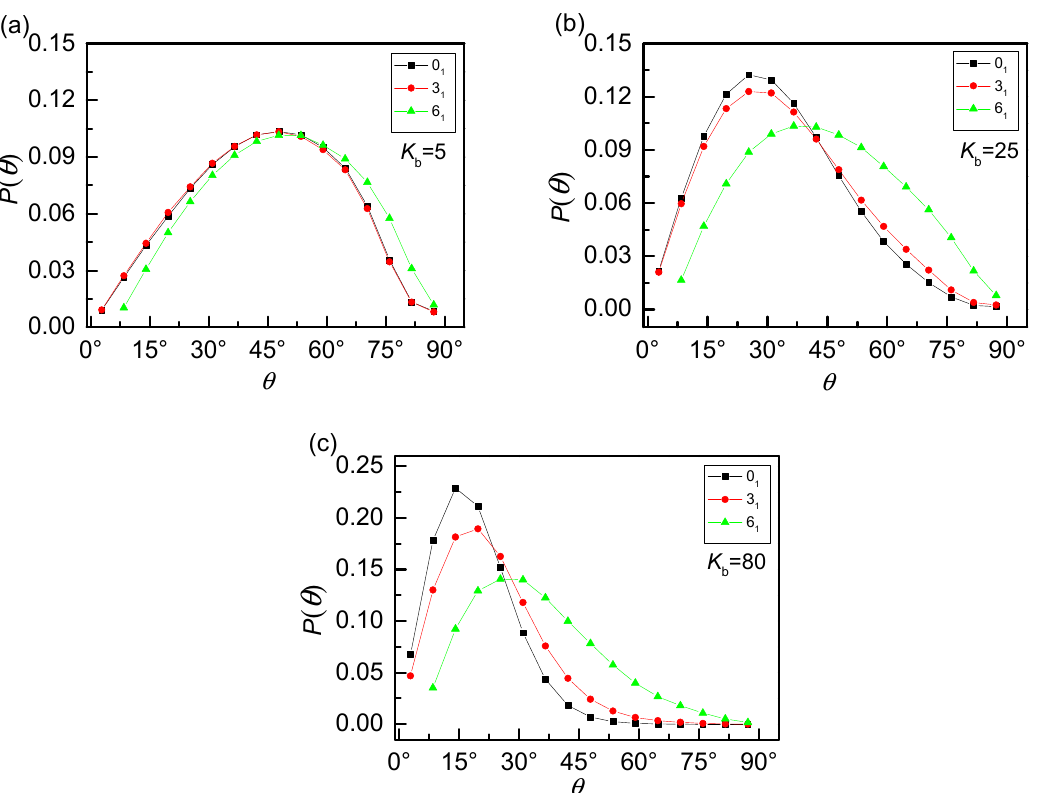
Figure 7. Probability distributions P( θ ) of threading angle for different bending energies ( a ) flexible rings, ( b ) semi-flexible rings, and ( c ) rigid rings with three knot types. The topology constraints suppress the anisotropic character, especially at the case of rigid rings.